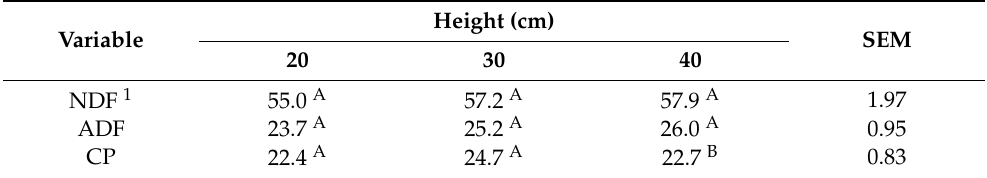
Table 5. Chemical composition (neutral detergent fiber, NDF; acid detergent fiber, ADF; and crude protein, CP; on % DM basis) of hand-plucked herbage samples of tangolagrass pastures subjected to different pre-grazing height targets (20, 30, or 40 cm) and the same intensity of defoliation (40% of the initial